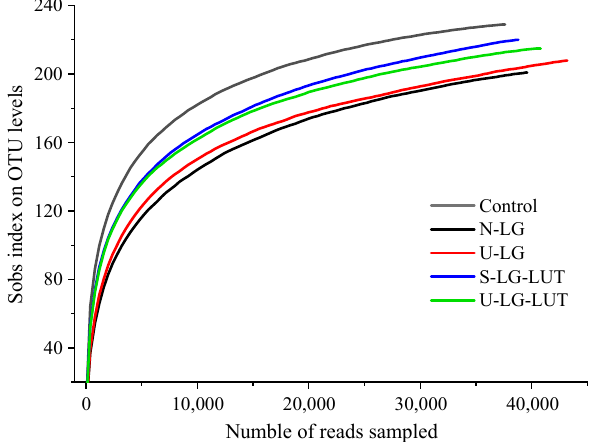
Figure 4. Dilution curves of high throughput sequencing results. Fig.4 Dilution curves of high throughput sequencing results.